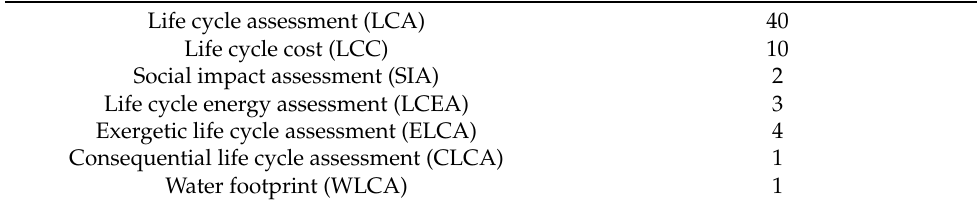
Table 5. LCT aspects and frequencies in the